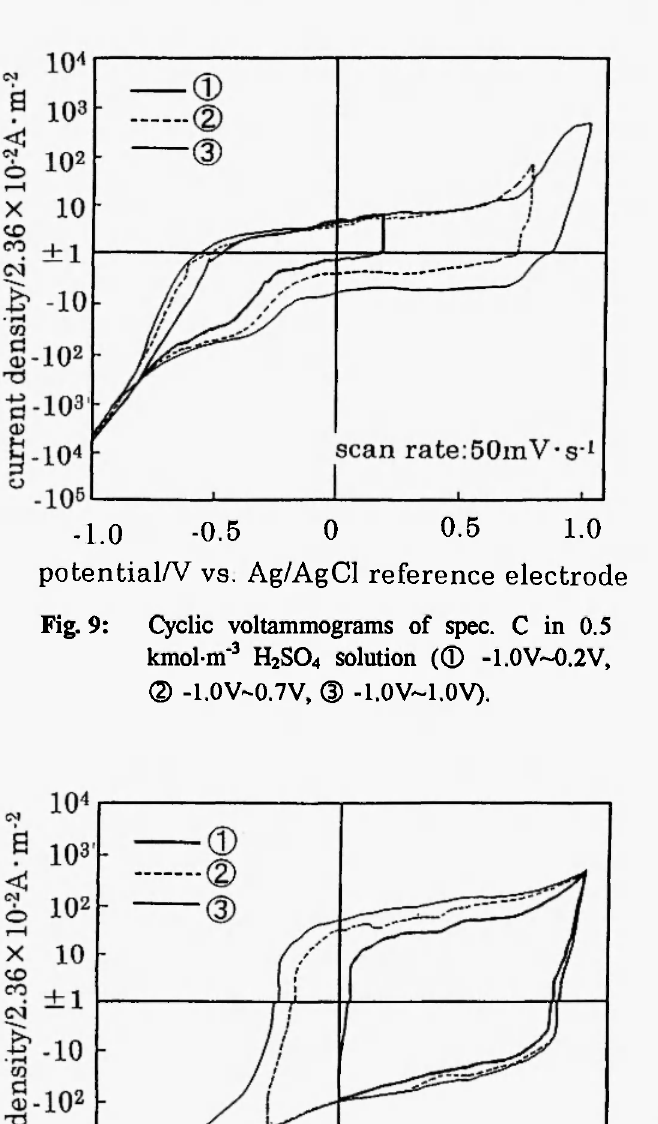
Fig. 10: Cyclic voltammograms of spec. C in 0.5 kmol-m" 3 H S0 solution (φ 0V-1.0V, 2 4 (D -0.3V~1.0V, (D -0.7~1.0V).